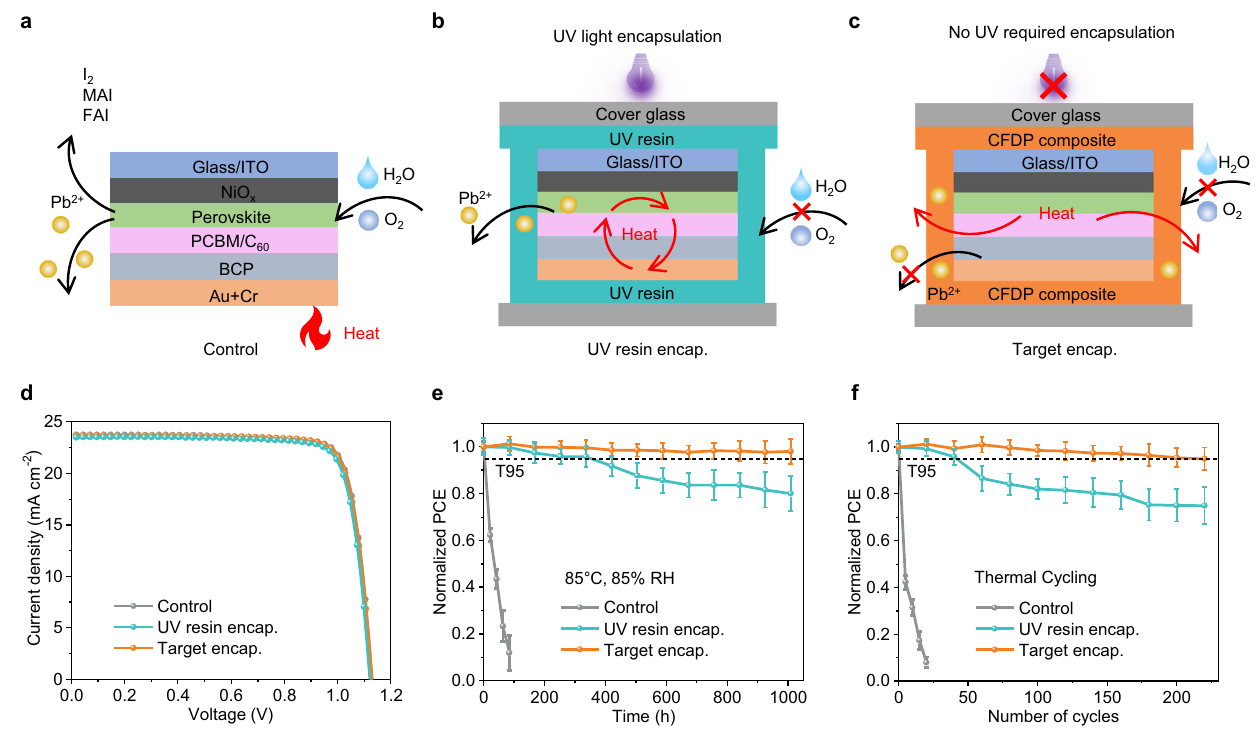
Fig. 3 | Photovoltaic performance of the PSCs. a – c Scheme of a the unencapsu- lated PSCs, b the PSCs with UV resin encapsulation, and c the PSCs with target encapsulation. d Thecurrentdensity – voltage( J-V )curvesofPSCsofthecontrol,UV resin encapsulation, and target encapsulation. e , f Ef fi ciency evolution of PSCs